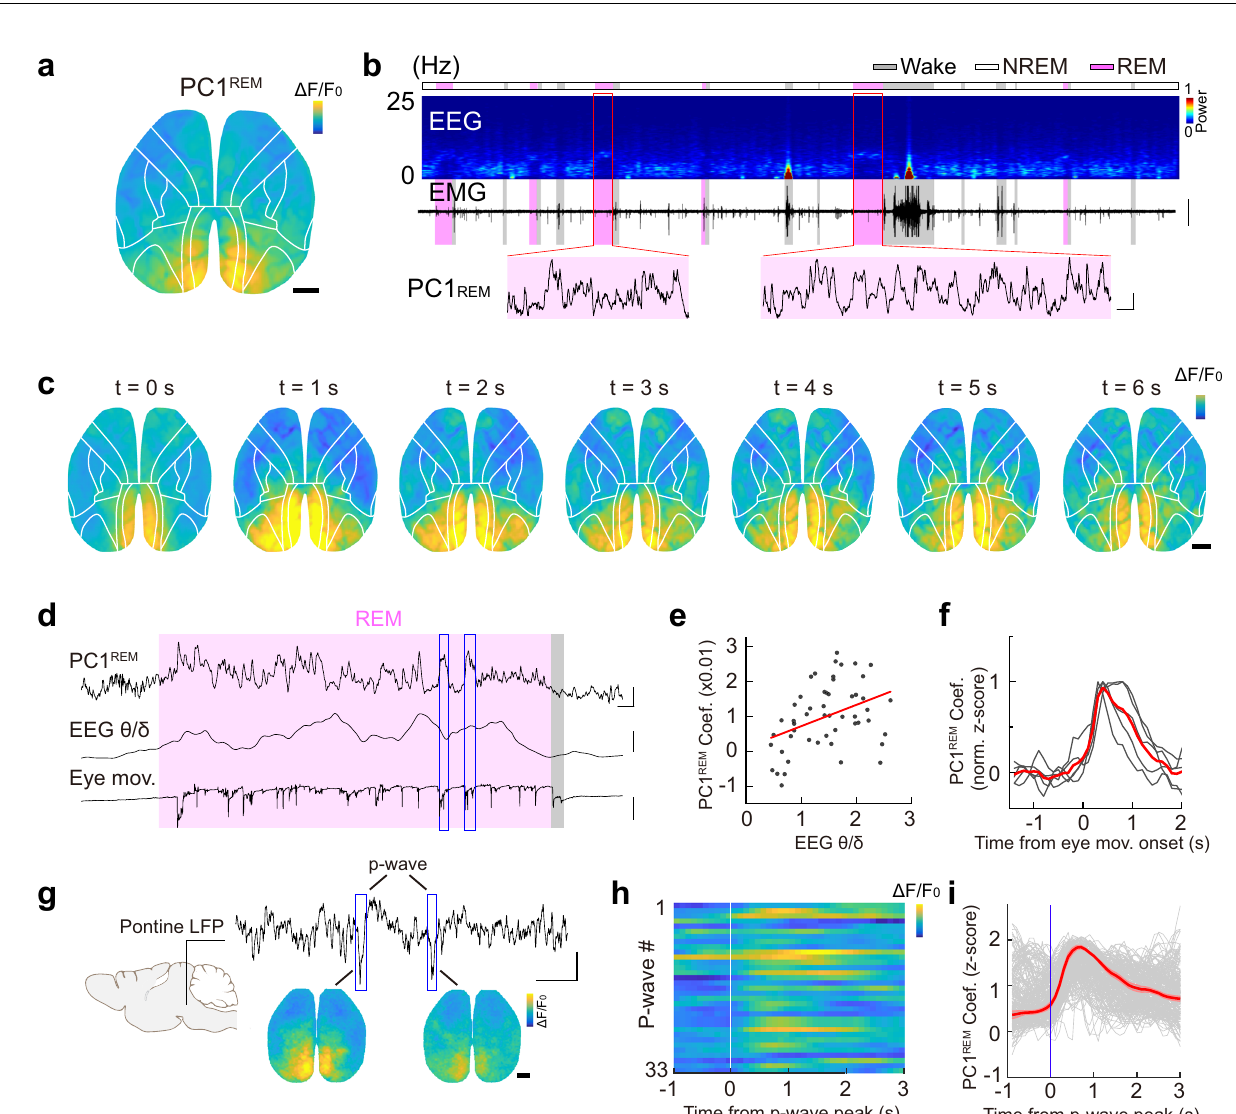
Fig. 3 | Highly structured cortical activation patterns during the sleep-wake cycle.a Activationpatternsin anexamplerecordingextracted usingPCA,showing the most frequently detected fi ve major PCs during the sleep-wake cycle. Scale ( Δ F/F 0 , z -score):PC1, − 2to 2;PCs 2 – 5, − 1.2 to 1.2. Black bar, 1mm. b Time course of EEG spectrum and the coef fi cient of PCs showing in panel a . Top to bottom, EEG powerspectrogram, EMG(scale, 0.5mV), coef fi cient ofPCs(scale,0.02and 100s). The brain states are color-coded; the same color code is used in all following fi gures. c Coef fi cient of the fi ve major PCs in different brain states. The same color codewasusedforeachPC,asshowninpanel b .Eachlinerepresentsdatafromone recording. * P <0.05, *** P <0.001; Two-tailed Student ’ s paired t test or Wilcoxon